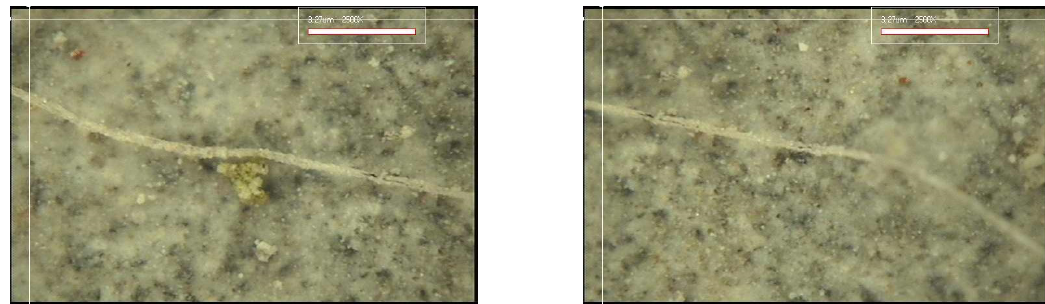
Figure 19. Surface crack monitoring of MCs 3%.